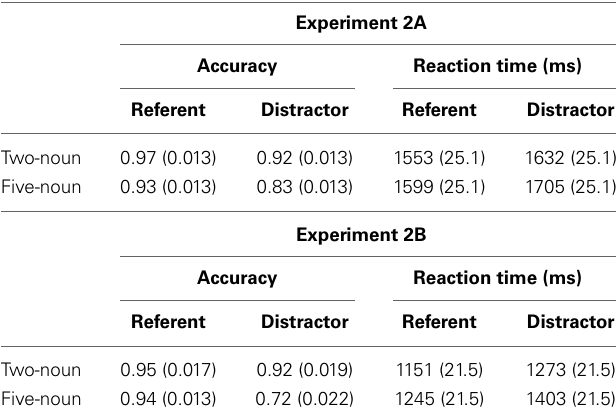
Table 5 | Experiments 2A and 2B mean probe word responses (with standard errors of the